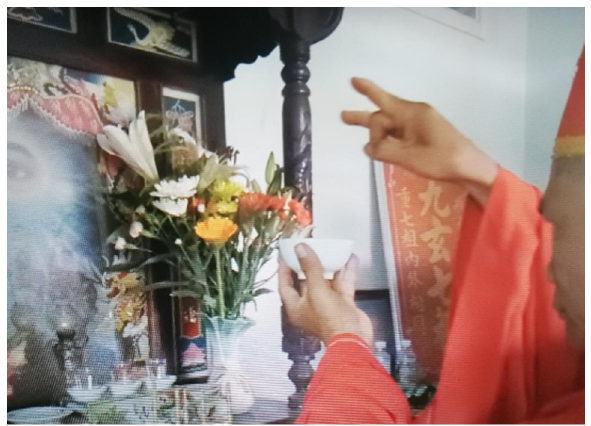
Figure 7. Talismanic writing for preparing the Cam L ồ water, and the seal of the Protector of Dharma, performed by a priest of Tây Ninh branch; funeral of Mrs Lê Th ị L ự c, 12 July 2017 (Ph ướ c D ươ ng 2017) .